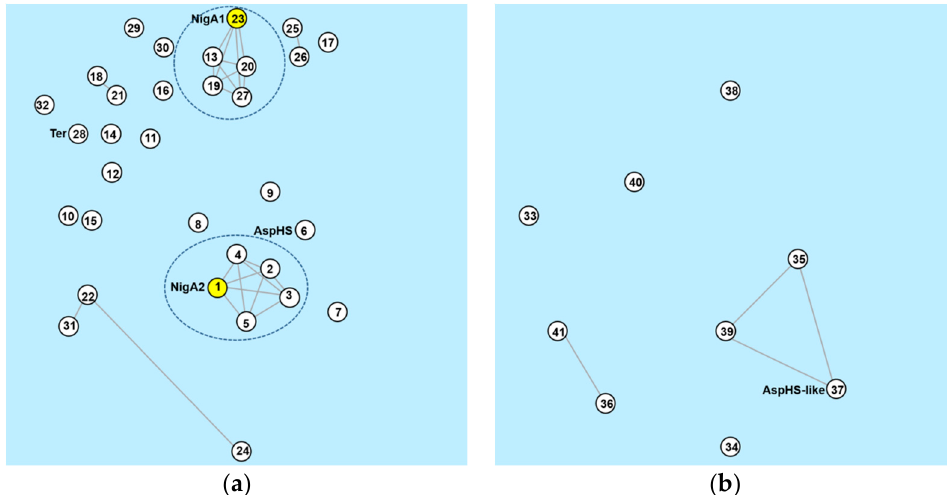
Figure 8. Orthologue group of aegerolysin protein sequences in genus Aspergillus . Group OG6_153003 ( a ), and OG6_454485 ( b ). A. niger Aspni7|1162650 (1), A. tubingensis Asptu1|141875 (2), A.